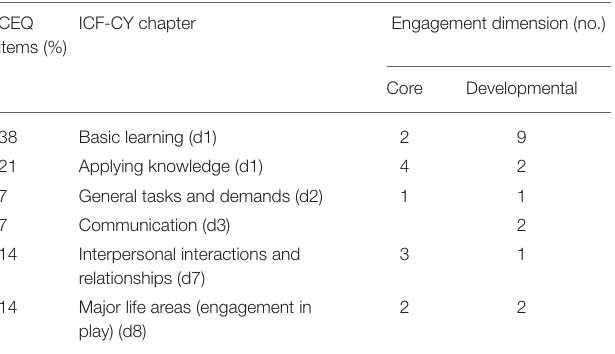
TABLE 3 | Distribution of CEQ items ( n = 29) across ICF-CY chapters and how the two dimensions of engagement were identified in the ICF-CY. CEQ ICF-CY chapter Engagement dimension items (%)